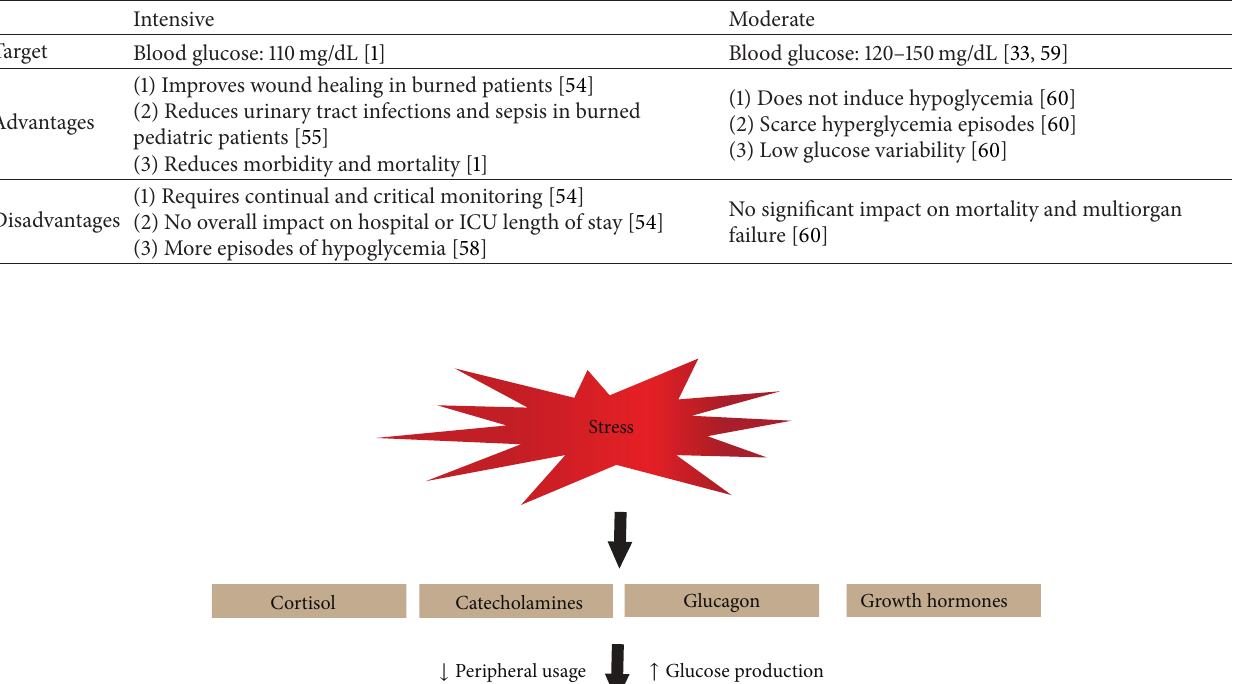
Table 2: Comparison of intensive and moderate insulin treatment.